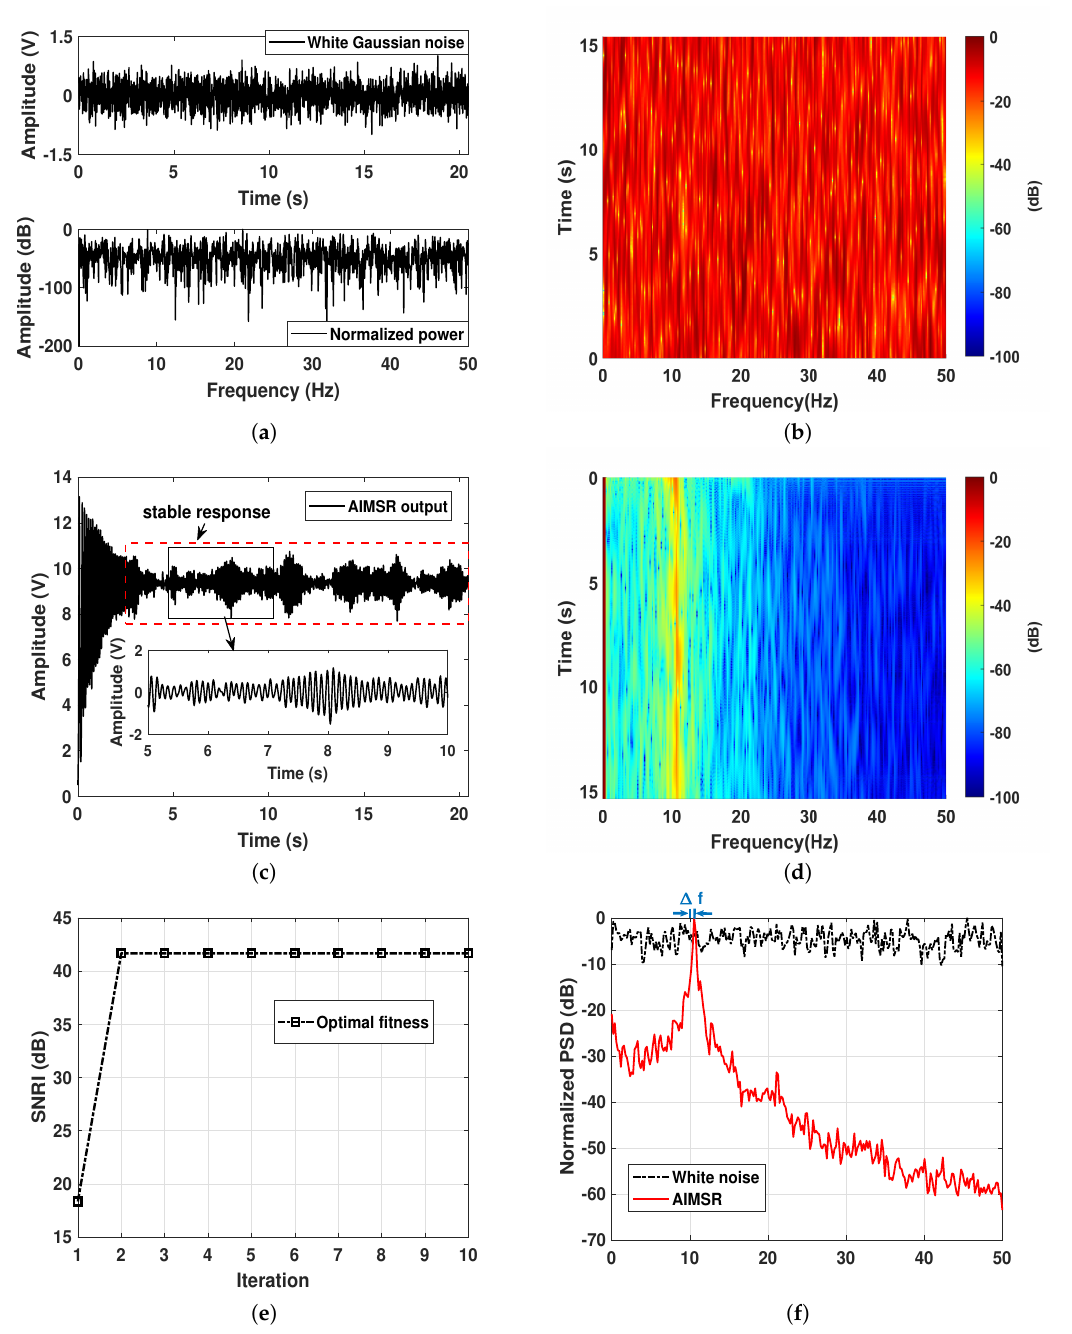
Figure 3. A simulation of discrete line signature signal on H 0 assumption: ( a ) the input waveform and its normalized power spectrum; ( b ) lofargram obtained with the input; ( c ) the AIMSR output waveform ( γ opt = 0.2875, K opt = 109.4507, h opt = 0.4465); ( d ) lofargram obtained with the AIMSR output; ( e ) the optimal fitness at each iteration with GA; ( f ) filtering performance comparison with normalized PSD (Welch